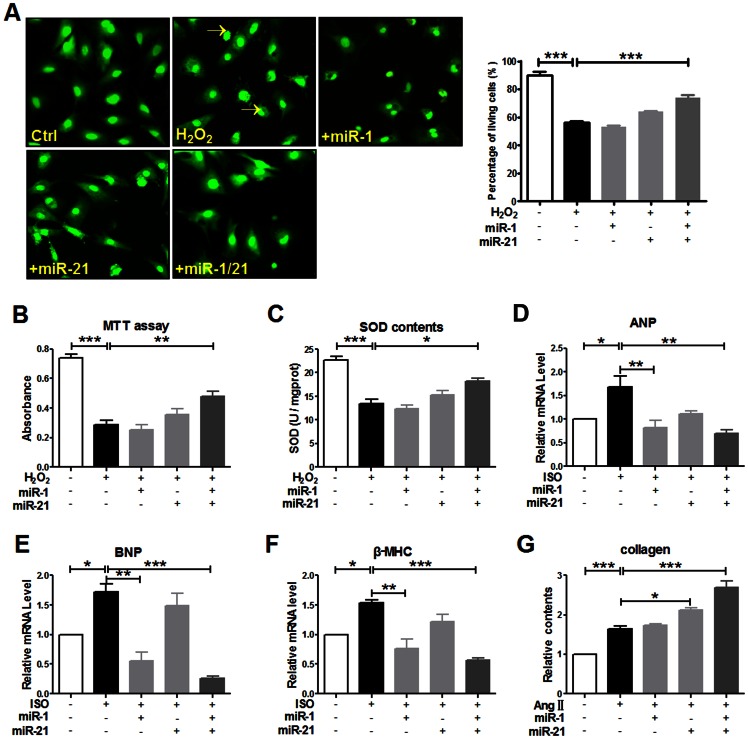
Experimental results of synergistic actions of miR-1 and miR-21.A. Results of AO/EB staining (neonatal rat ventricular CMs, 100×magnification). The yellow arrows point to the apoptotic cells. Left panel: result of cell counting. ***p<0.001 Ctrl vs H2O2 treatment group; ***p<0.001 miR-1 and miR-21 co-transfection group vs H2O2 treatment group; At least a sum of 100 cells were counted in four fields per group. B. Results of MTT assay (neonatal rat ventricular CMs). **p<0.01, ***p<0.001 vs H2O2 treatment group; n = 5. C. Measurement of SOD contents (neonatal rat ventricular CMs). *p<0.05, ***p<0.001 vs H2O2 treatment group; n = 5. D. Quantitative RT-PCR results of gene expression of ANP (neonatal rat ventricular CMs). *p<0.05, **p<0.01 vs ISO treatment group; n = 5. E. Quantitative RT-PCR results of gene expression of BNP (neonatal rat ventricular CMs). *p<0.05, **p<0.01, ***p<0.001 vs ISO treatment group; n = 5. F. Quantitative RT-PCR results of gene expression of β-MHC (neonatal rat ventricular CMs). *p<0.05, **p<0.01, ***p<0.001 vs ISO treatment group; n = 5. G. Measurement of collagen contents (neonatal rat CFs). *p<0.05, ***p<0.001 vs AngII treatment group; n = 5. AO/EB staining: Acridine orange/ethidium bromide staining; CMs: cardiomyocytes; CFs: cardiac fibroblasts; quantitative RT-PCR: quantitative reverse transcription–polymerase chain reaction. ANP: atrial natriuretic peptide; BNP: brain natriuretic peptide; β-MHC: beta myosin heavy chain; ISO: isoproterenol; AngII: angiotensinII.